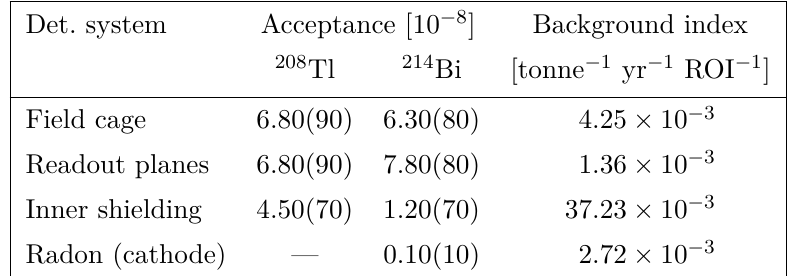
Figure 8 . Left: total background activity before cuts for the dominant sources in the NEXT-1t radioactivity budget. The figures shown here result from the product of the activities listed in table 1 (assuming secular equilibrium of the decay chains) multiplied by the mass or surface of each material in NEXT-1t. In the case of Kapton, 1 m 2 = 0 . 413 kg . Right: activity remaining after selection cuts.